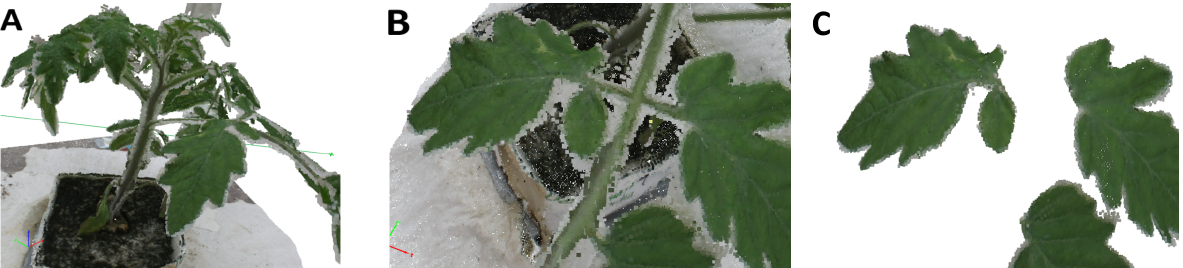
( C ) preparation (leaves only). The point size was enhanced for